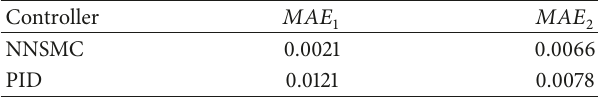
Table 1: The mean absolute errors of NNSMC and PID controller.